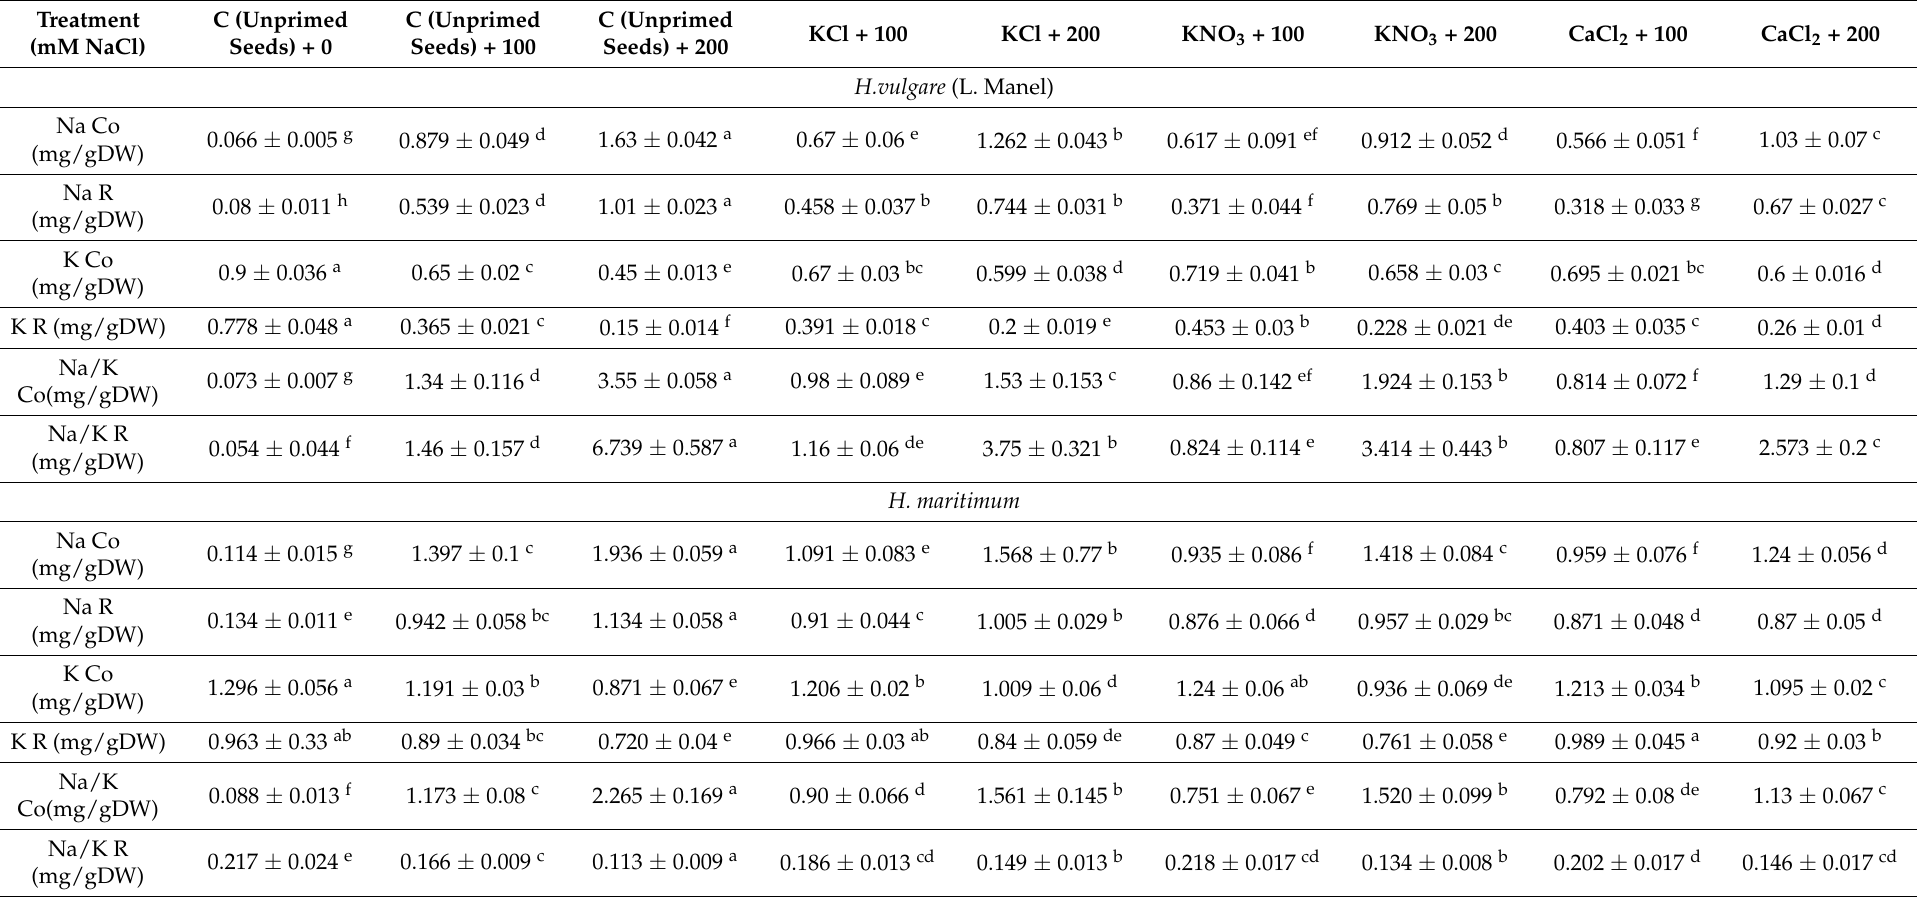
Values are the means of 5 independent replicates ± standard error. Data with the same letter are not significantly different at p < 0.05 (Duncan’s